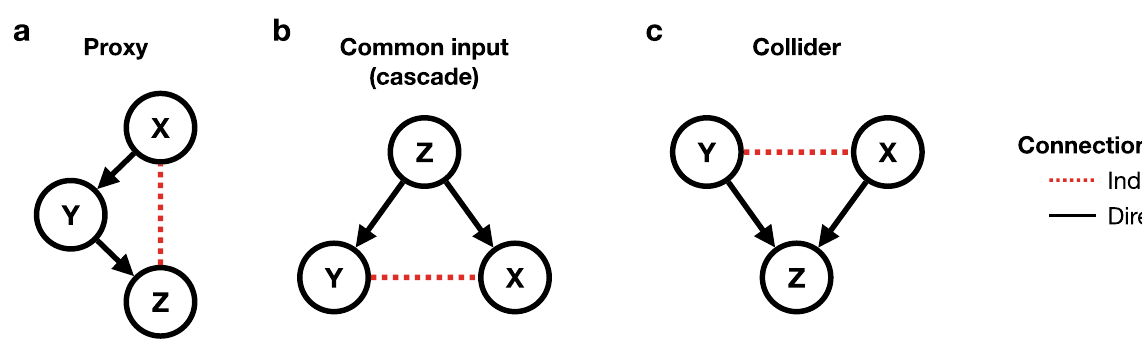
Figure 1. Overview of connectivity motifs 23–25 that can lead to incorrect inference without pairwise and partial analysis. Arrows indicate variable definitions. For example, X → Y denotes that Y is generated by adding noise to X, while X is independently generated. ( a ) X and Z will exhibit a non-zero pairwise relationship, however controlling for Y will eliminate this indirect relationship. ( b ) Y and X will exhibit a non-zero pairwise relationship, however controlling for Z will eliminate this indirect relationship. ( c ) When Y and X are independent, a partial analysis between them conditioned on Z will produce a non-zero